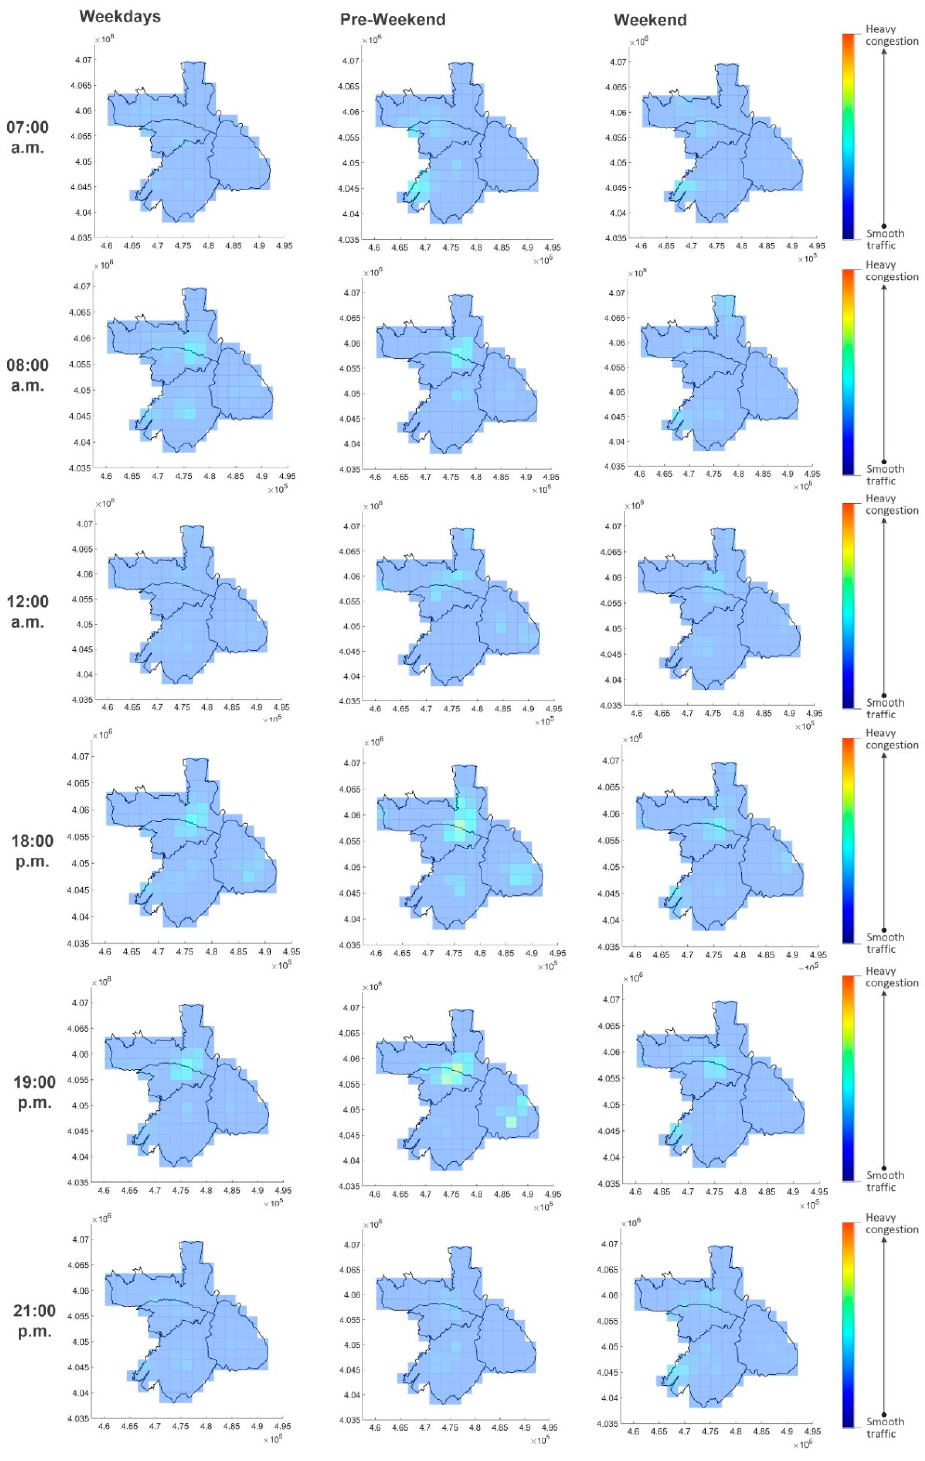
Figure 4. Evolvement of traffic condition during weekdays, the day before weekend (Friday) and weekend.